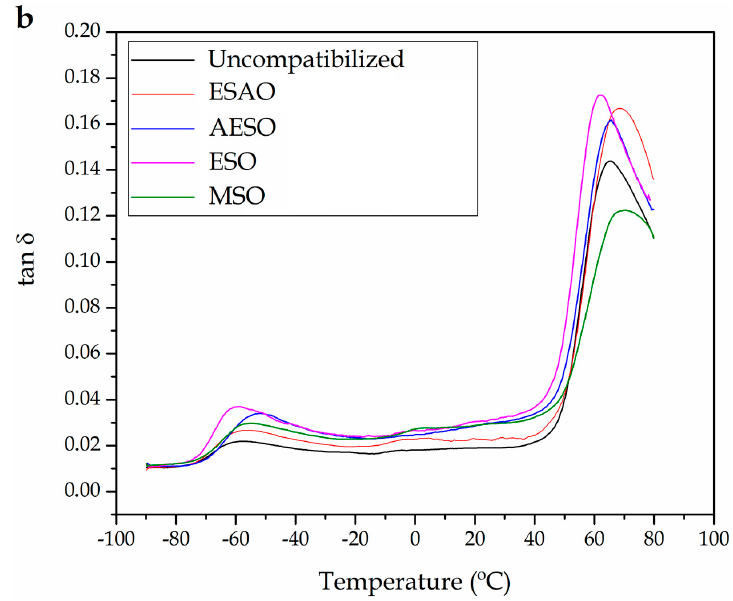
Figure 5. Comparative dynamic-mechanical thermal analysis (DMTA) curves of PLA 60 /PHB 10 /PCL 30 blend with different compatibilizers, ( a ) storage modulus, E’ and ( b ) damping factor (tan δ ).